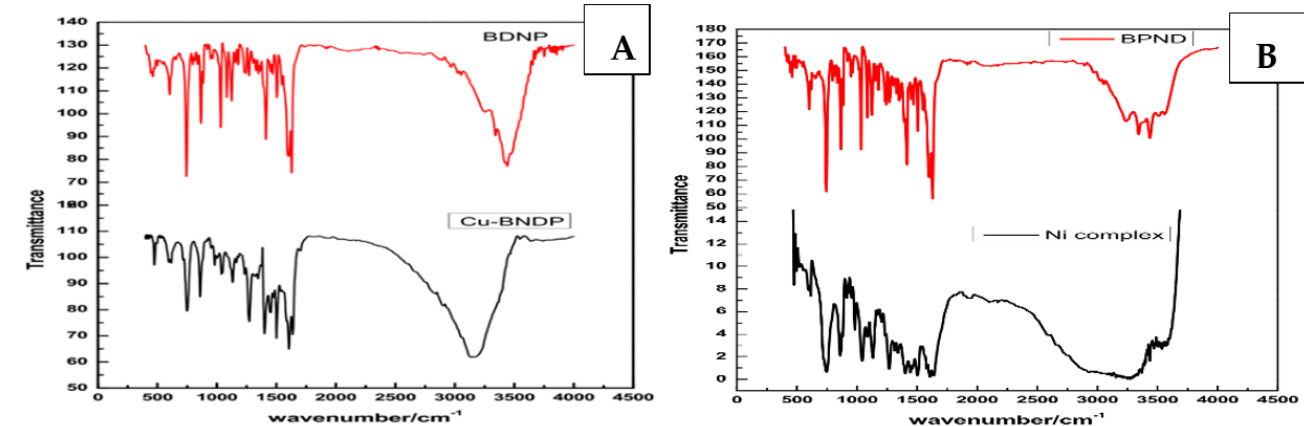
Figure 1. FT-IR spectra for a BPND and Cu-BPND complex ( A ) and FT-IR spectra for a BPND and Ni-BPND complex ( B ). KBr was used as a sample matrix, such as in BPNDs in the spectral range of 400–4000 cm − 1